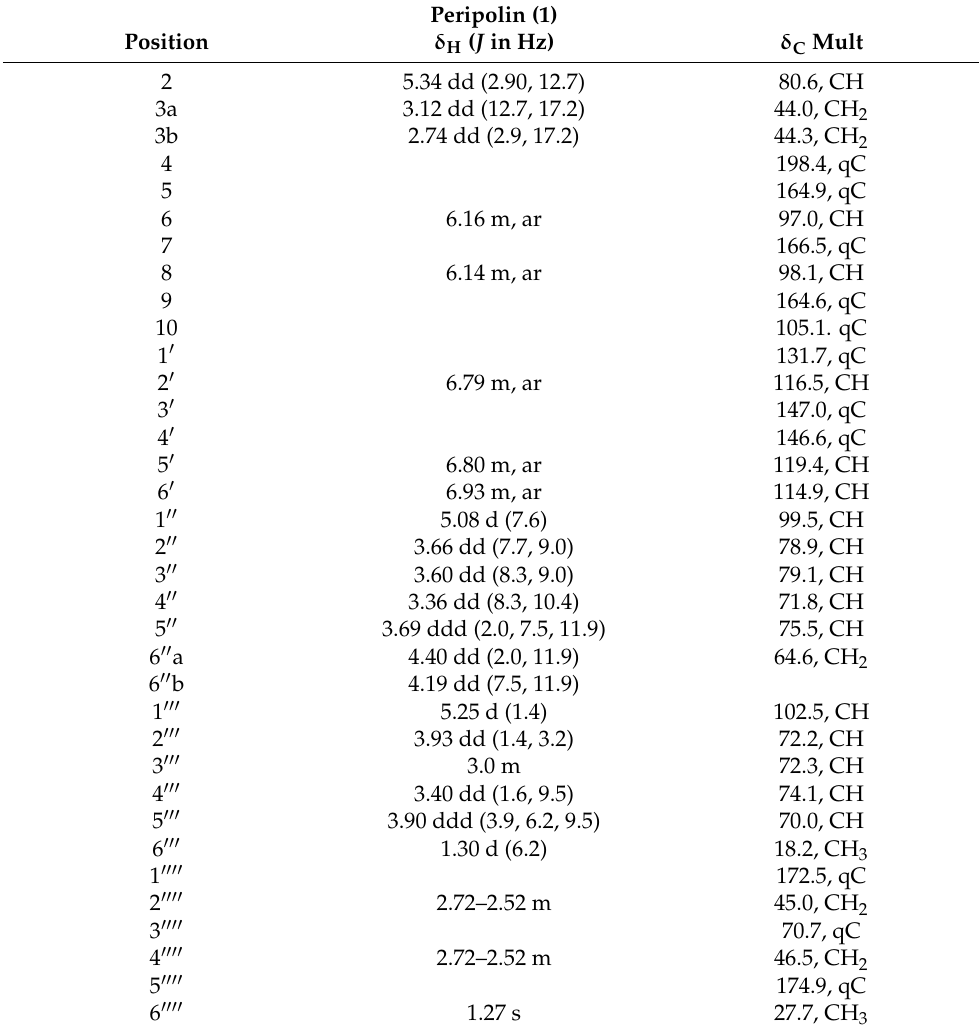
Table 1. 1 H NMR and 13 C NMR Spectroscopic Data for Compounds 1